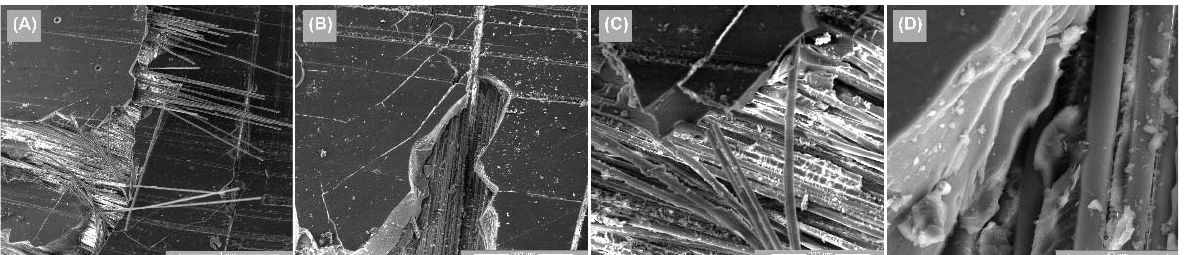
Figure 16. Surface SEM images of longitudinal 0–90 GFRP sample: ( A ) 100×, ( B ) 200×, ( C ) 500×, and